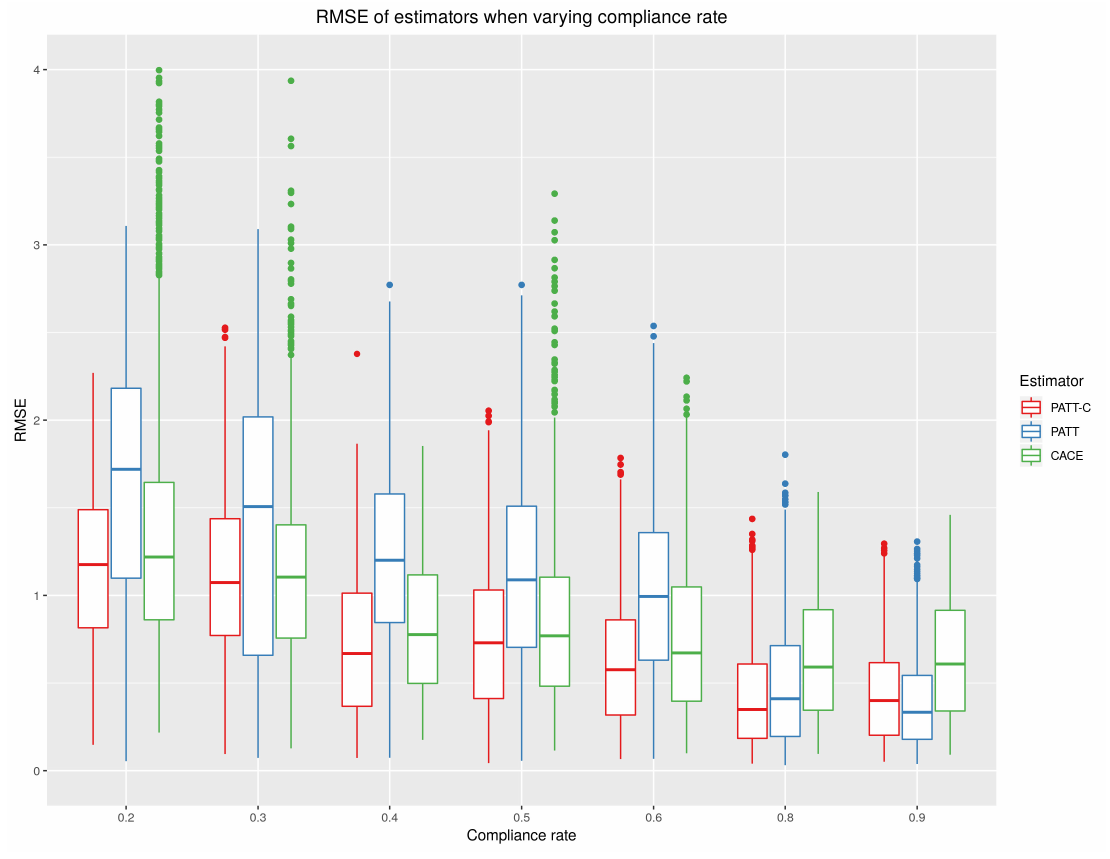
Figure 4: Average RMSE according to compliance rates in the